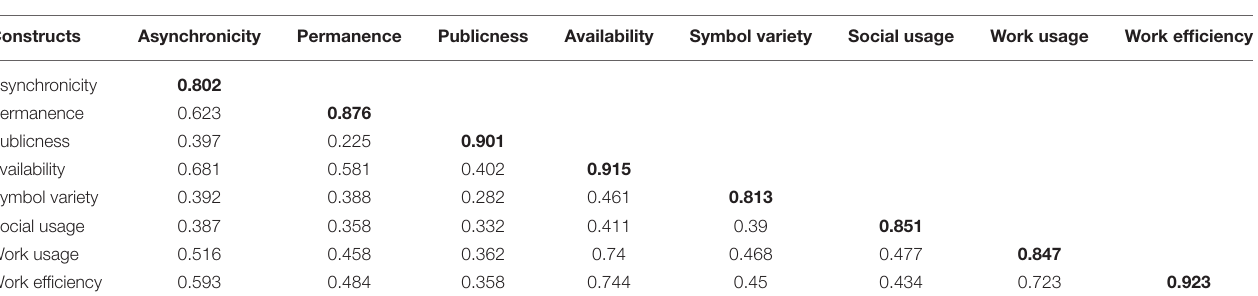
TABLE 3 | Correlation coefficient matrix between latent